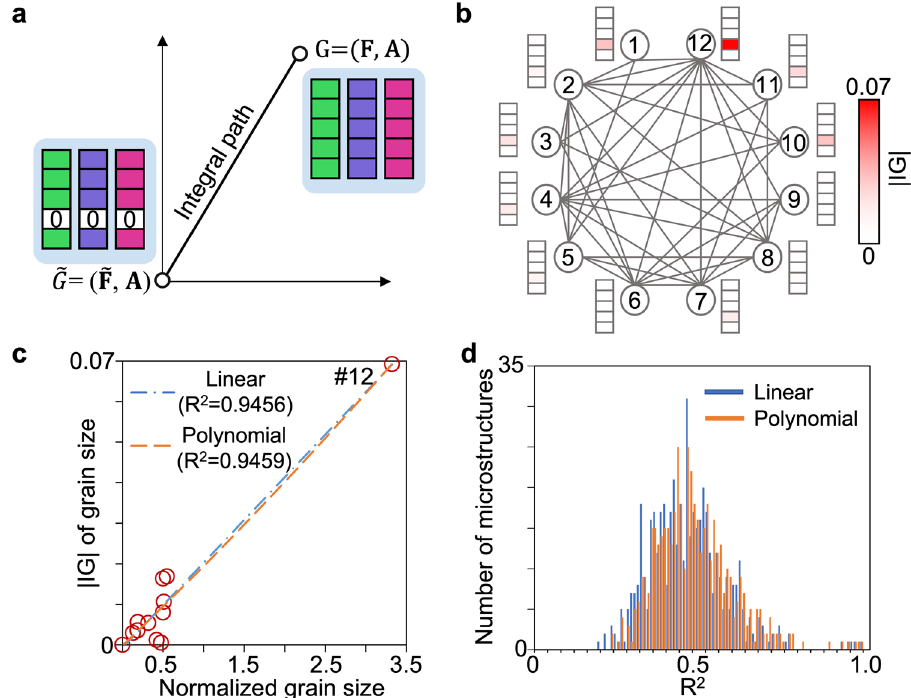
Fig. 6 Integrated Gradient (IG) analysis. a Schematic of the IG calculation by de fi ning a baseline graph ~ G , where the grain size is set to be zero in all nodes while the values of the other four-node features are set to be the same as those of the target graph G . b Node-resolved absolute IG values of a 12-node microstructure graph. c Correlation analysis between the absolute value of the normalized grain size and its corresponding absolute IG value for this 12-node graph by both linear and polynomial fi tting. d The distribution of the R 2 factor obtained through linear fi tting and polynomial fi tting for all the 492 microstructure